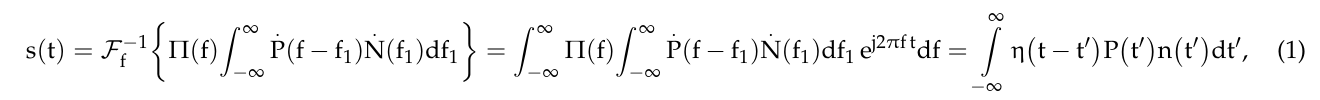
power spectral density of the probing signal.